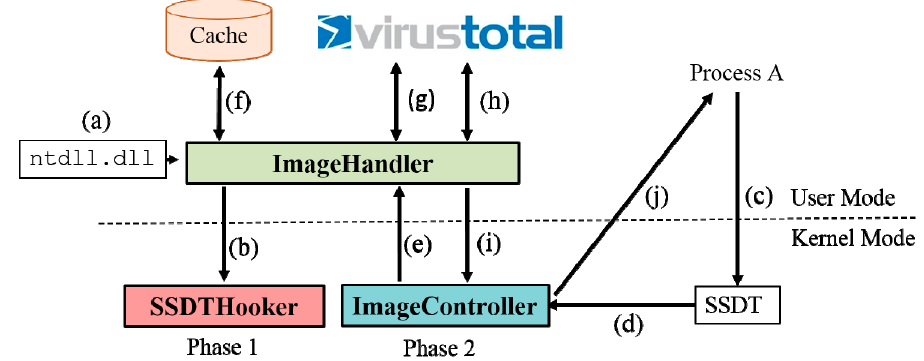
Figure 3. System structure and execution flow of major Skywalker components.